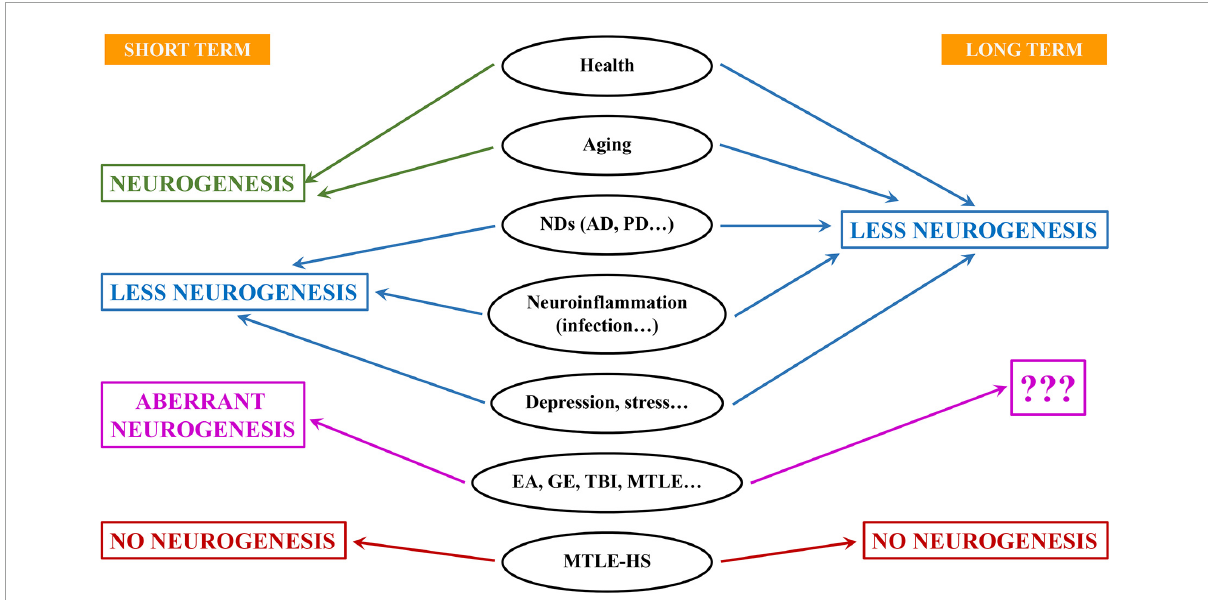
FIGURE2 Different outcomes for neural stem cells and neurogenesis in aging, disease and damage. Aging, neurodegeneration and infection are accompanied by neuroinflammation and typically associate with lower levels of neurogenesis at least in the long term. On the contrary, situations of neuronal hyperexcitation (EA, epileptiform activity; GE, generalized epilepsy; TBI, traumatic brain injury; MTLE, mesial temporal lobe epilepsy) usually trigger an increase of neurogenesis in the short term. However, neurons born under these conditions are aberrant. It is not clear whether this effect is stained in long-term. In more severe forms of epilepsy such as MTLE with hippocampal sclerosis (MTLE-HS), neurogenesis is drastically impaired even in the short term.